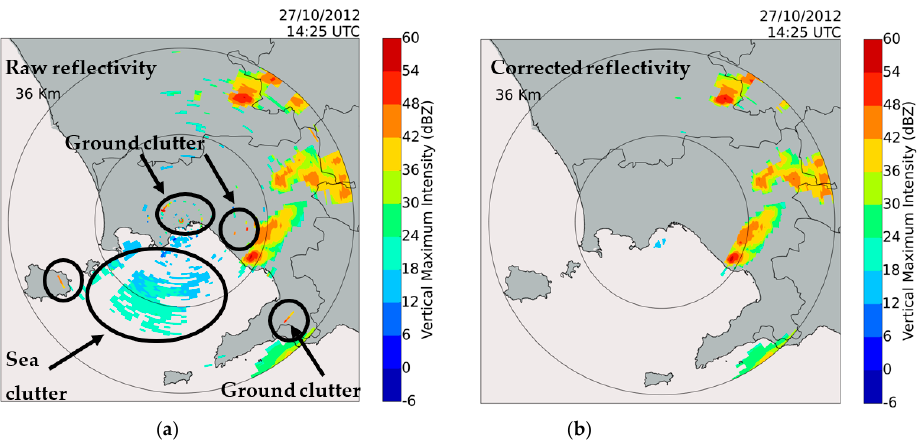
Figure 2. In ( a ), the Vertical Maximum Intensity (VMI) reflectivity map collected by WR-10X on 27 October 2012 at 14:25 UTC is presented. The zoom on Naples Gulf emphasizes the presence of ground and sea clutters, whose most important evidences are indicated by black circles. Panel ( b ) shows the same reflectivity map, obtained after applying the quality control algorithms developed to suppress ground and sea